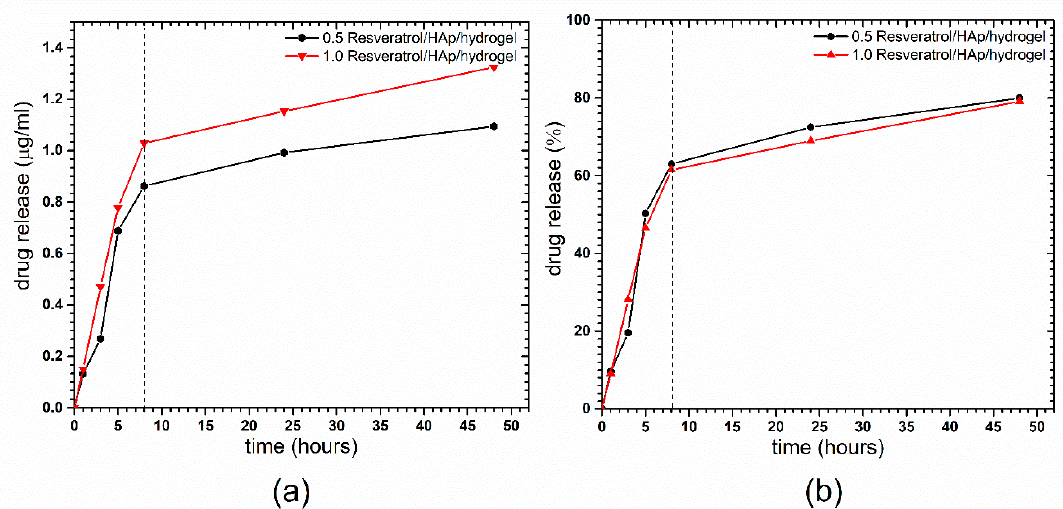
Figure 6. Time dependent the resveratrol release from the loaded nHAp/hydrogel presented as released mass ( a ) of the RES and its percentage ( b ).